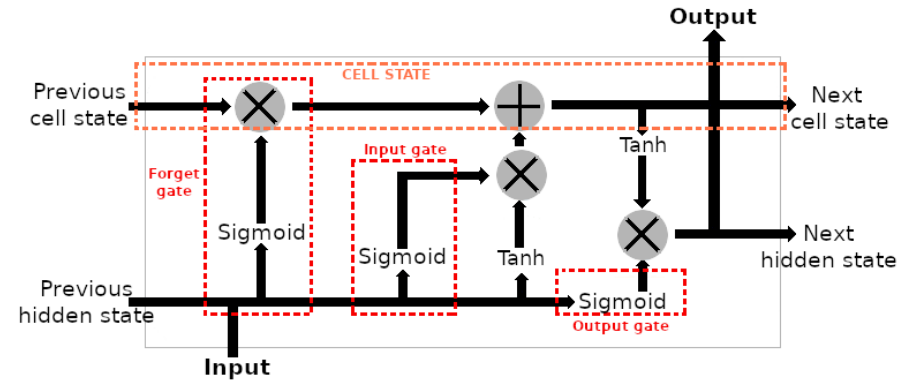
Figure 8. The LSTM cell